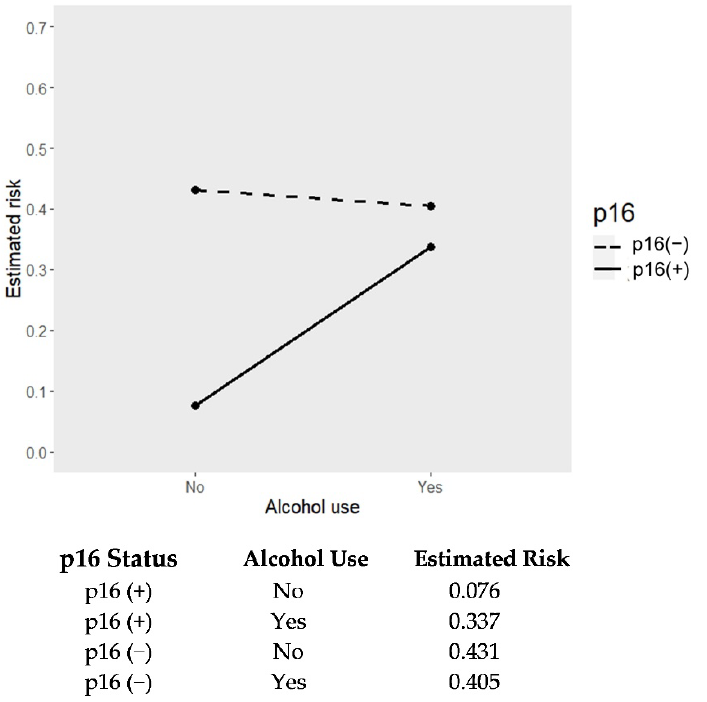
Figure 2. Interaction plot for estimated risk of disease relapse according to p16 status and alcohol use. Table 4. The cumulative risks of disease relapse in HPV-related oropharyngeal cancer by alcohol and smoking